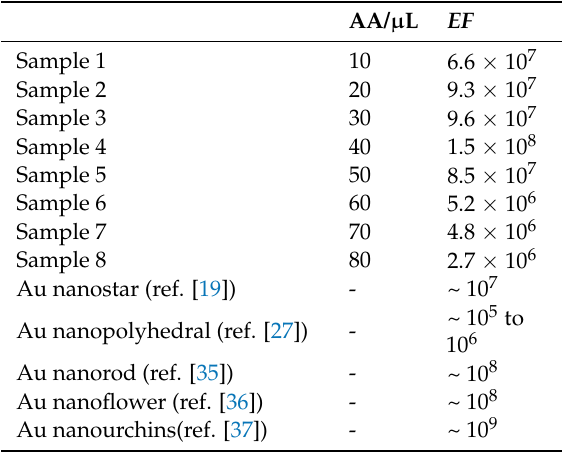
Table 2. The calculated enhancement factors of the synthesized AuNBr with different amounts of AA